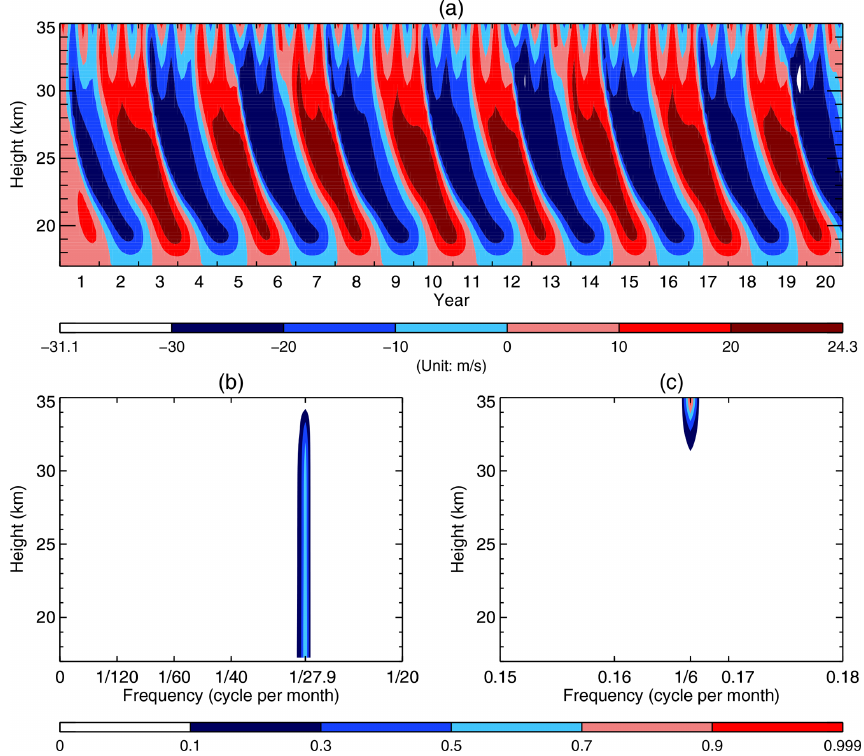
Figure 3. (a) Same as Fig 2a but with the enhanced α(z) depicted as the red line in Fig. 1a. (b, c) Frequency–height section of the power spectral densities (PSDs) of the standardized monthly averaged mean zonal wind of the 100 years. Note that in order to better visualize the PSDs in (b) and (c) , we trimmed off the blank segments for the frequencies ranging from 1 from 0.18 to 0.5 cycles per